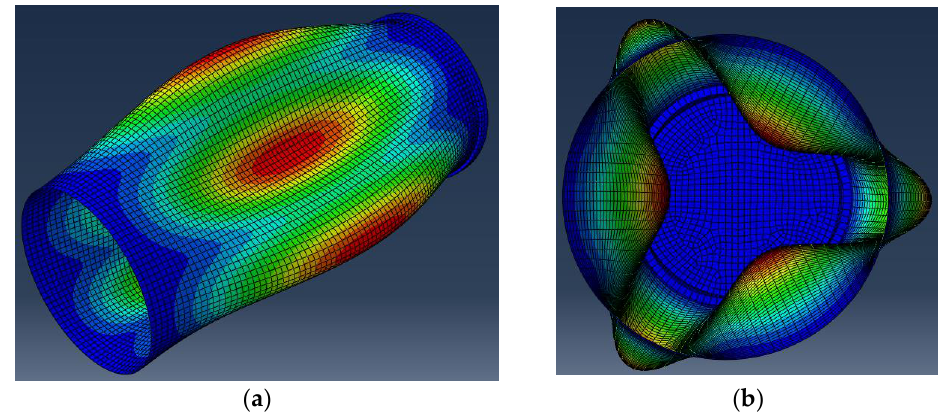
Figure 3. Buckling mode shape for composite cylindrical shell: ( a ) front view; ( b ) left view.